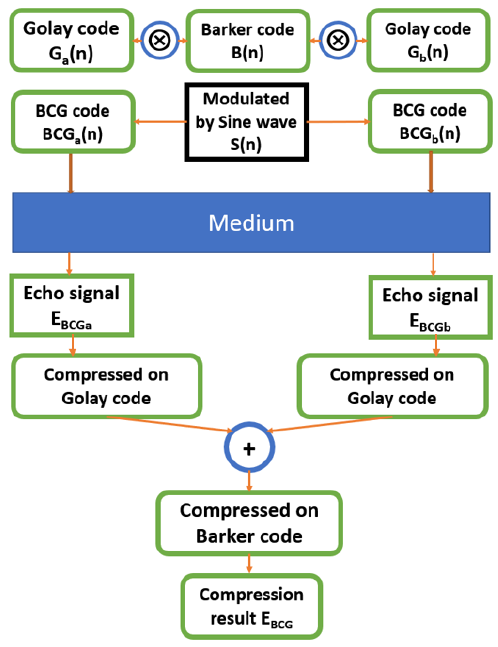
Figure 2. The process of generation and compression of the sequence of a Barker code combined with Golay code pair.